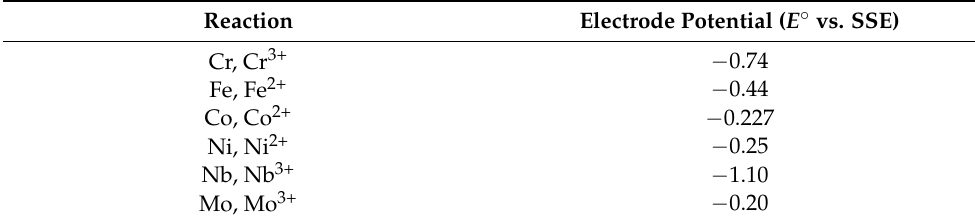
Table 4. Standard electrode potential at 25 °C [25].